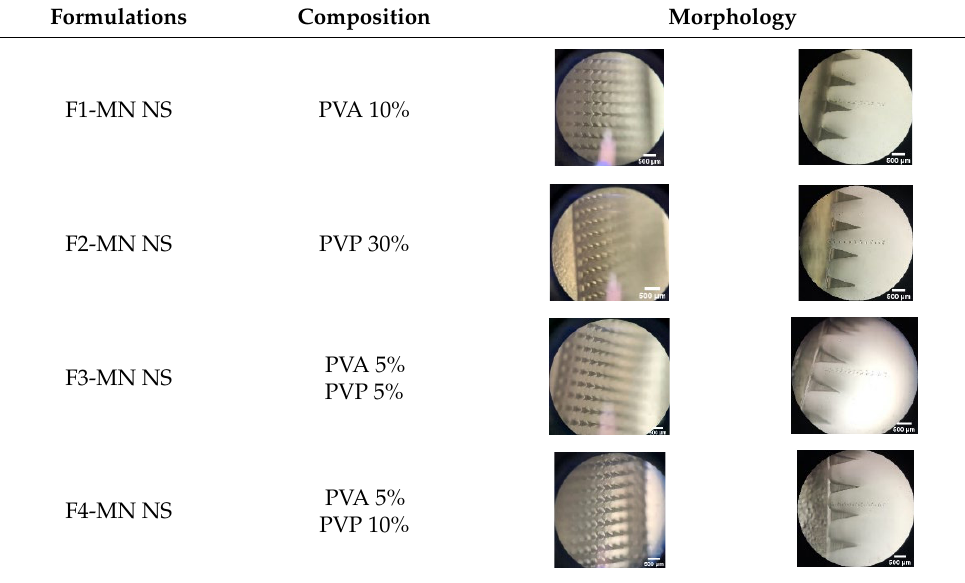
Table 5. Observation Results of Dissolving Microneedle Loaded with Co-grinded Ketoprofen Through a Microscope (scale bar: 500 µm). (PVA: polyvinyl alcohol; PVP: polyvinyl pyrrolidone; Keto: Ketoprofen). Formulations Composition